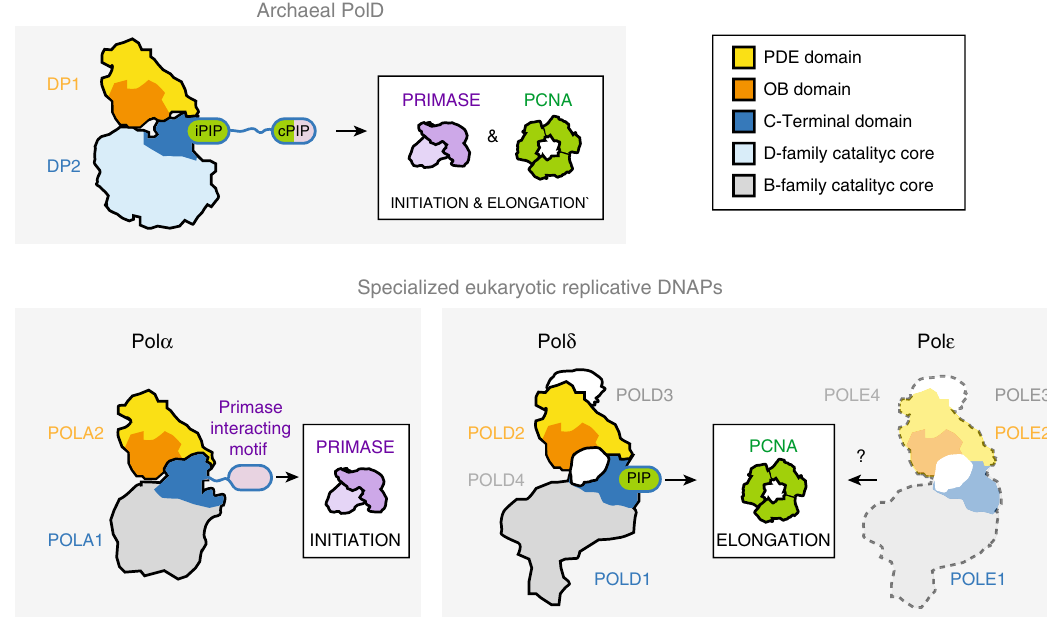
Fig. 6 Comparison of multi-subunit polymerases in Archaea and Eukarya. The binding modes of PCNA and primase are illustrated in a schematic way and the two PIP motifs (cPIP and iPIP). The schematic representations are derived from the structures of the human Pol α -primase complex (PDB ID: 5EXR), the human Pol δ -PCNA complex (PDB ID: 6TNY), and the P. abyssi PolD – PCNA complex (this study). No structures are currently available for the PCNA – Pol ε complex, but its schematic representation is supported by the literature 68